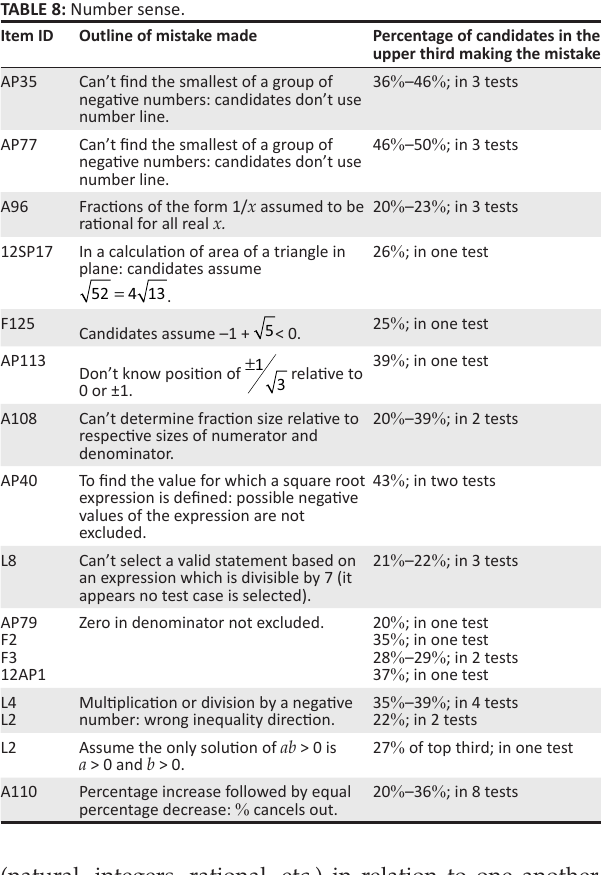
upper third making the